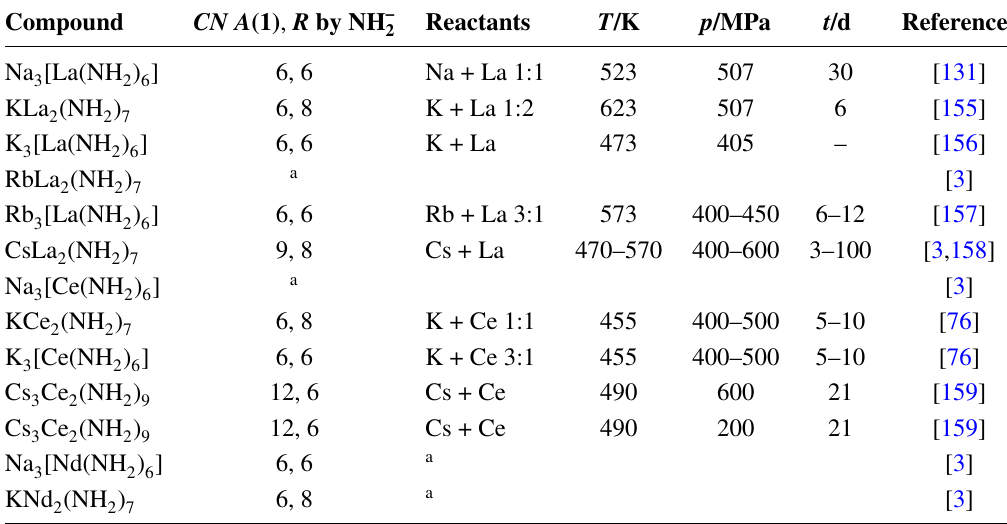
Table 6. Conditions for the ammonothermal synthesis of ternary amides containing rare-earth metals and coordination numbers of the metal atoms by amide ions.